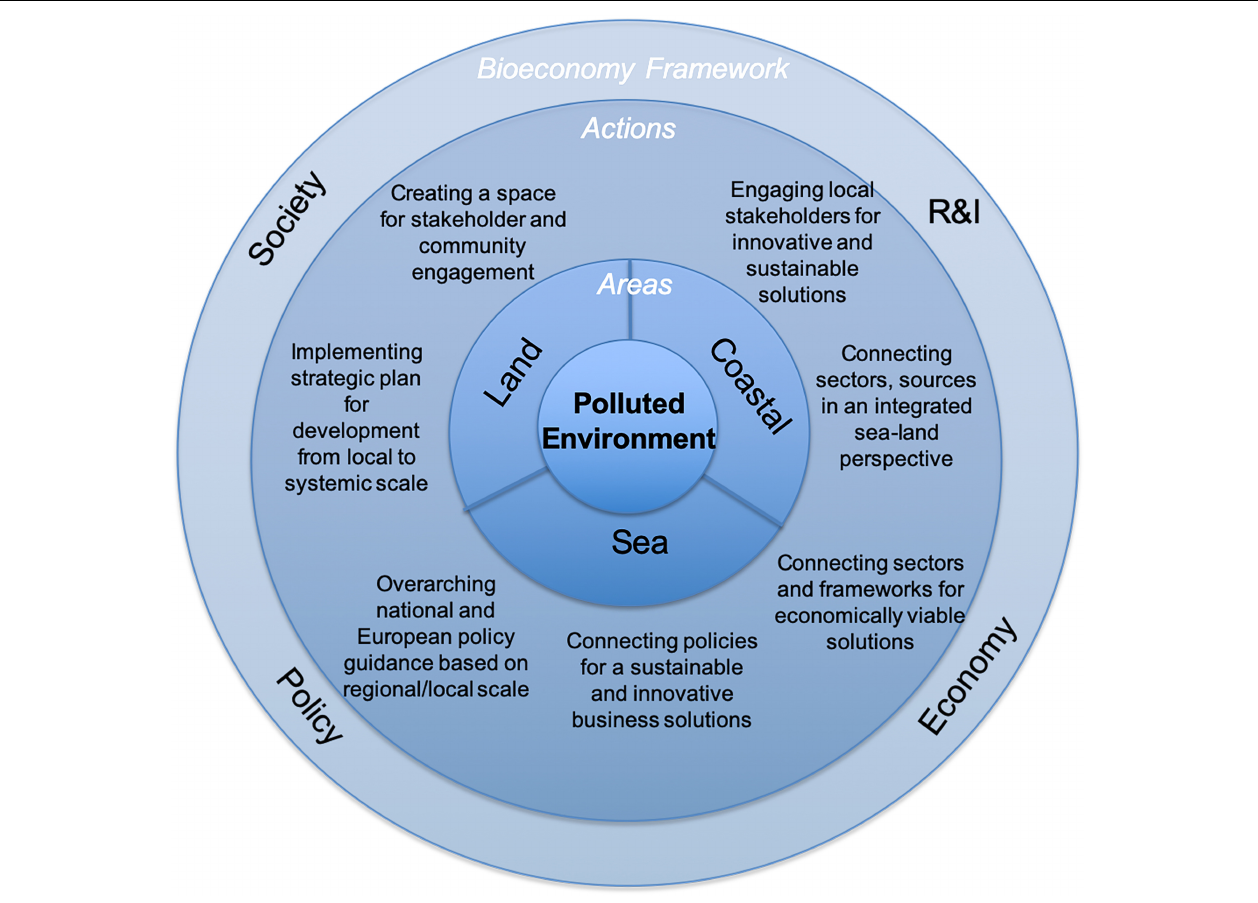
FIGURE 3 | Integrated concept for the management of contaminated areas in a circular bioeconomy perspective. The proposed conceptual model highlights areas, actions, and framework that would potentially contribute to the design of a comprehensive strategy of the polluted environment.